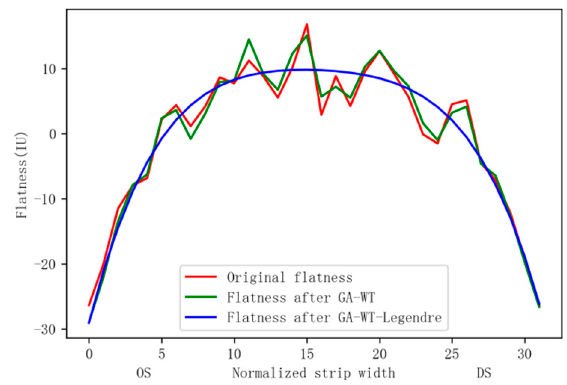
Figure 6. Comparison of the three flatnesses.